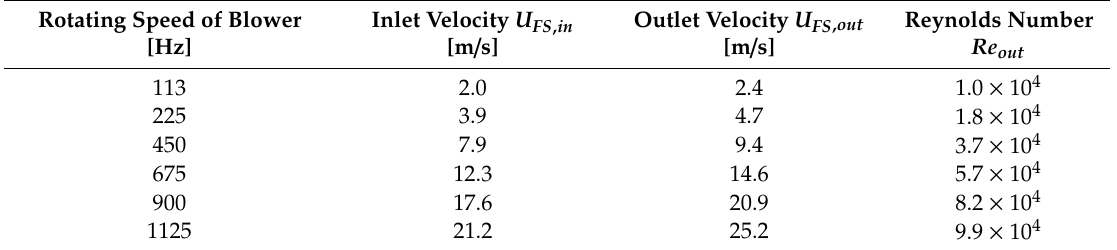
Table 2. Inlet and outlet freestream velocity and Reynolds number of linear turbine cascade. Rotating Speed of